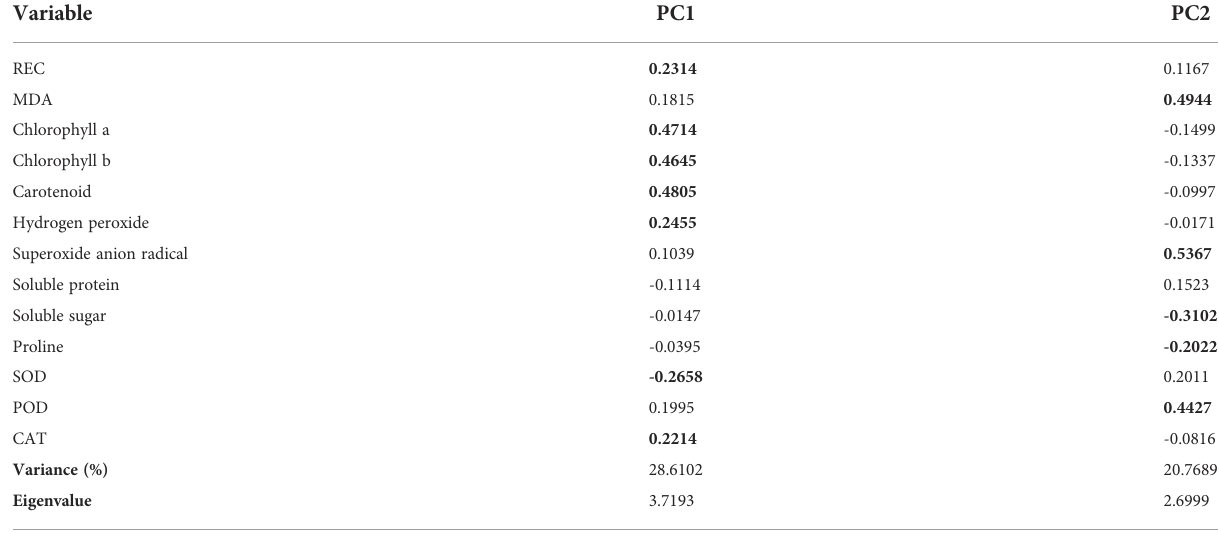
TABLE 1 Variable loading, percentage variation and eigenvalue derived from PCA for the measured characteristics in three mangrove species under all upwelling treatments.